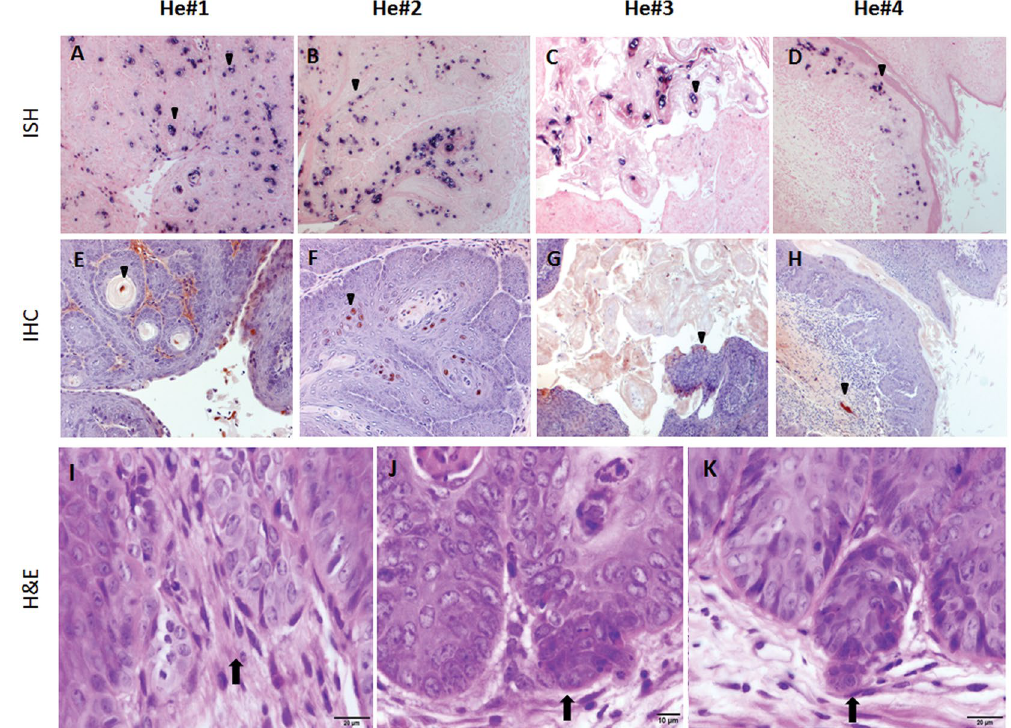
Figure 5. NU/J heterozygous (immunocompetent) mice developed productive viral infections in vaginal tissues; carcinoma in situ was detected at 7.5 months post infection. MmuPV1 DNA was detected in infected vaginal tissues in NU/J heterozygous mice (He#1-#4) upon sacrifice at 7.5 months post-infection by in situ hybridization (ISH, A – D , 10 × , and arrows). Capsid protein was detected by immunohistochemistry using an in-house anti-MmuPV1 monoclonal antibody (MPV.B9, ( E – H ), 10 × , and arrows). Cell morphology was examined by H and E . Carcinoma in situ was diagnosed in the vaginal tracts of all animals and ambiguous stromal micro-invasion by basal cells ( I – K , 20 × , and arrows) and scattered foci of ambiguous micro invasion were found in